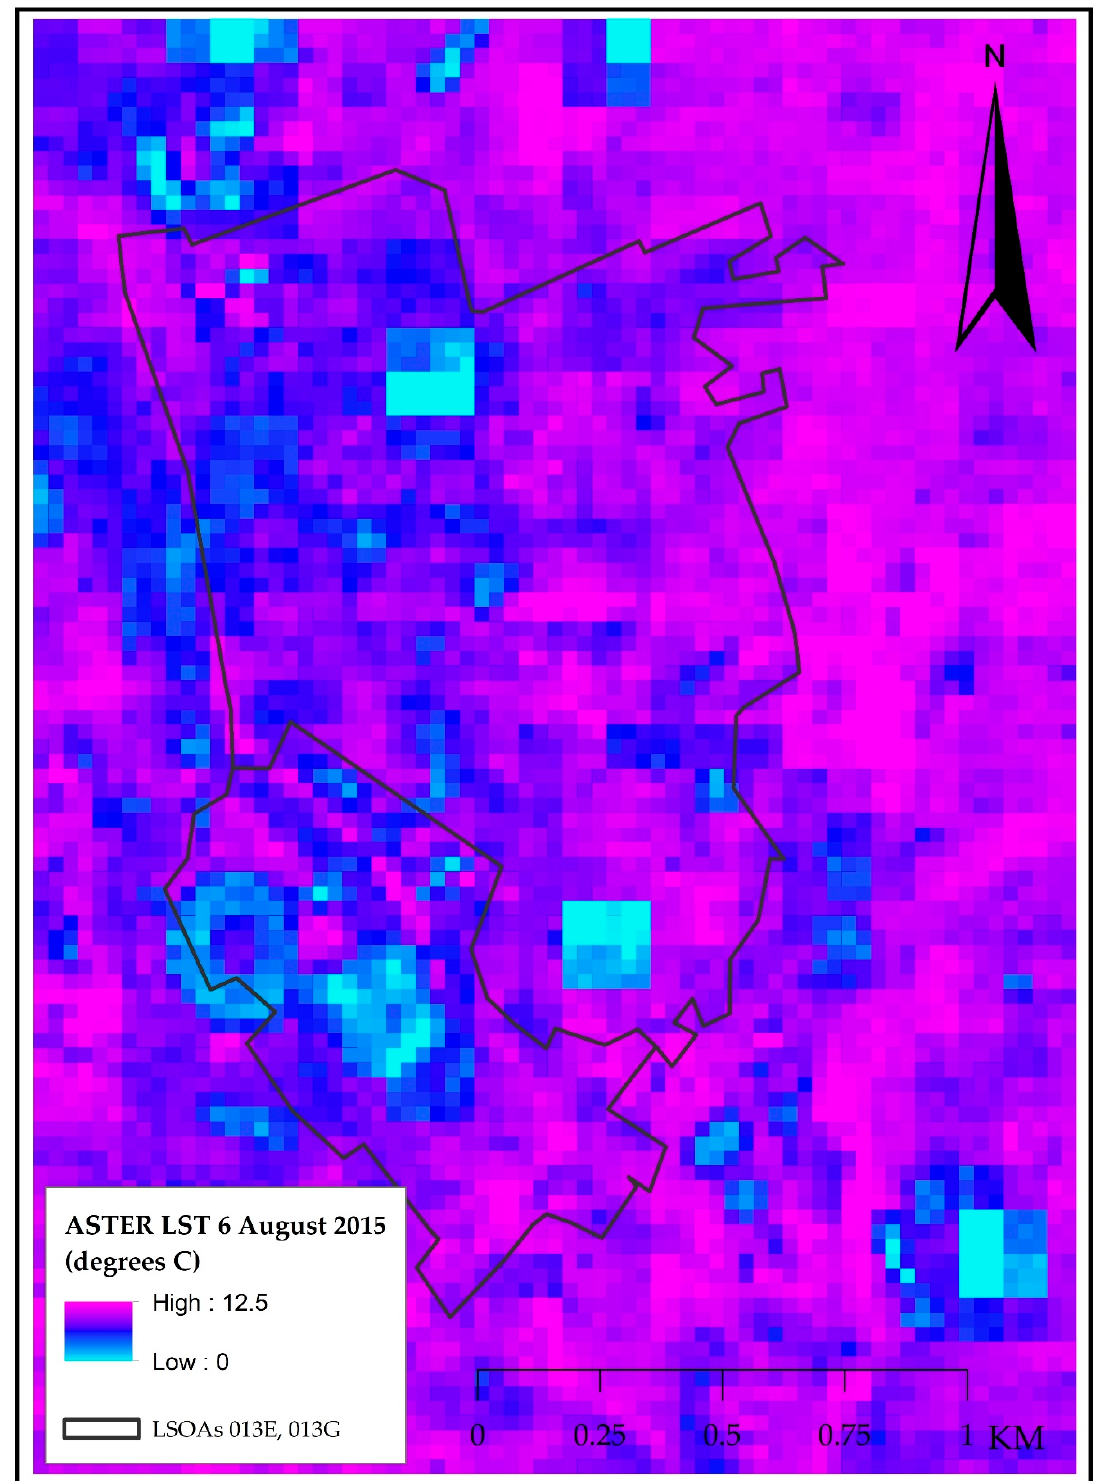
Figure 8. Land surface temperature development over the area of Stratford London (LSOAs 013E, 013G), as derived from ASTER imagery acquired at 9:45 p.m. U.T. on 6 August 2015. Contains National Statistics data © Crown Copyright and database right (2015) and (2012). Contains Ordnance Survey data © Crown Copyright and database right (2015) and (2012).